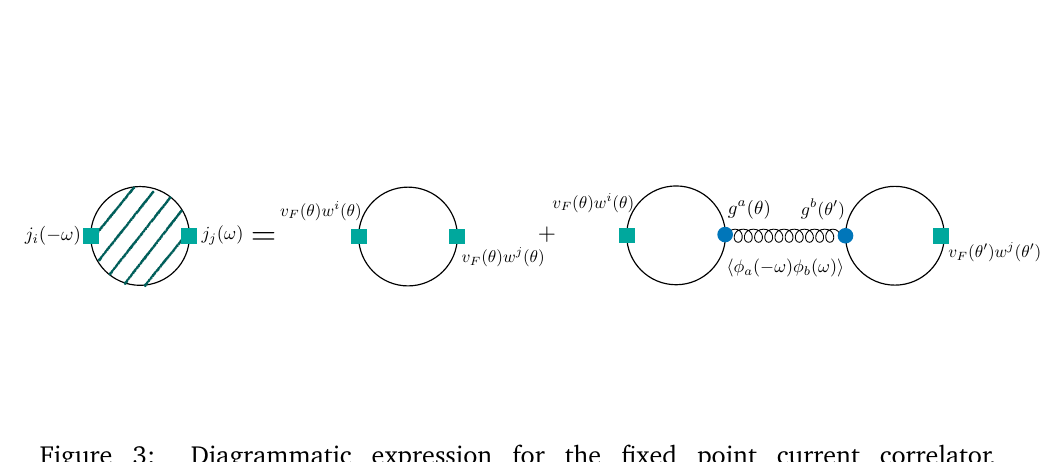
Figure 3: Diagrammatic expression for the fixed point current correlator, 〈 j ( − ω , q = 0 ) j ( ω , q = 0 ) 〉 , obtained in Eqs. (63) and (64). Here we define boxes i j ( θ ) w i ( θ ) , and circles as boson- as current insertions, which introduce factors of v F fermion vertices, which introduce factors of g a ( θ ) . Solid lines denote bare fermion propagators, and the curly line denotes the full boson propagator including all quan- tum corrections, which we determined using the U ( 1 ) anomaly in Eq. (47). Be- patch cause at zero momentum the boson couples strongly to each of the patches, every closed fermion loop involves a sum over the patch index, θ . Computing these dia- grams reproduces the expression we obtained in Eq. (63), meaning that all additional corrections involving internal boson propagators